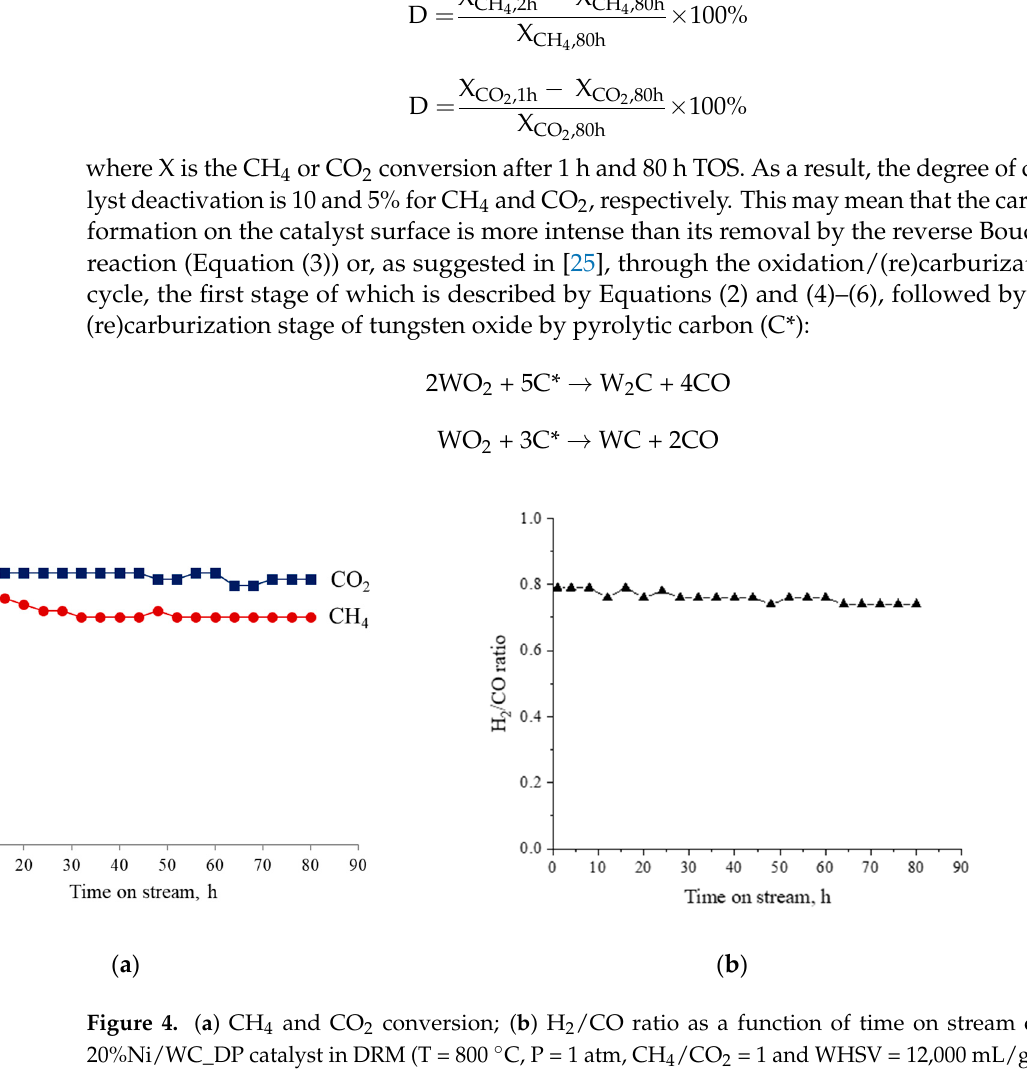
Table 2. Ni-WC, Co-WC and WC catalysts used in DRM.